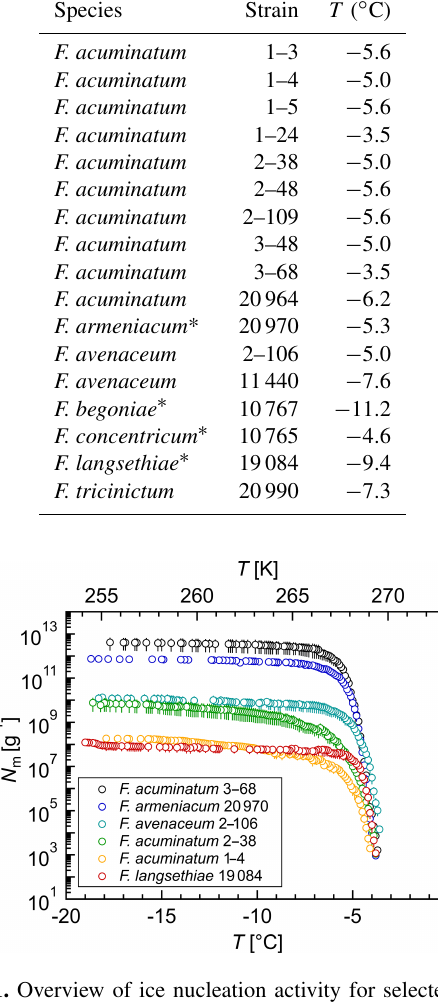
Figure 1. Overview of ice nucleation activity for selected Fusar- ium species and strains: cumulative number of IN ( N m ) per gram of mycelium plotted against the temperature ( T ); arithmetic mean val- ues and standard error of two independent experiments with aque- ous extracts from two individual fungal culture plates of the same